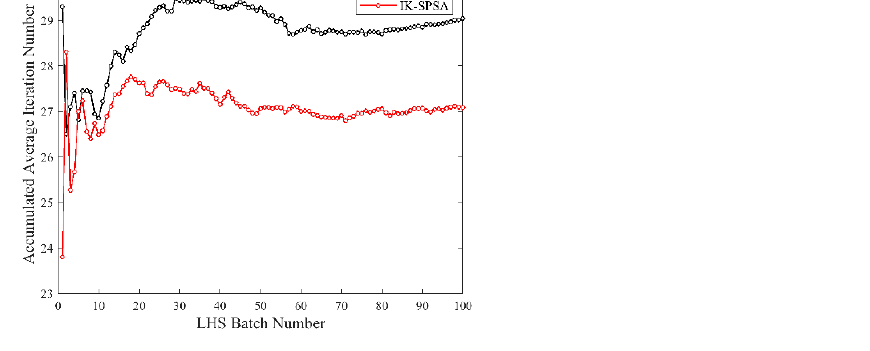
Figure 22. Accumulated average iteration number distribution at different initial points.